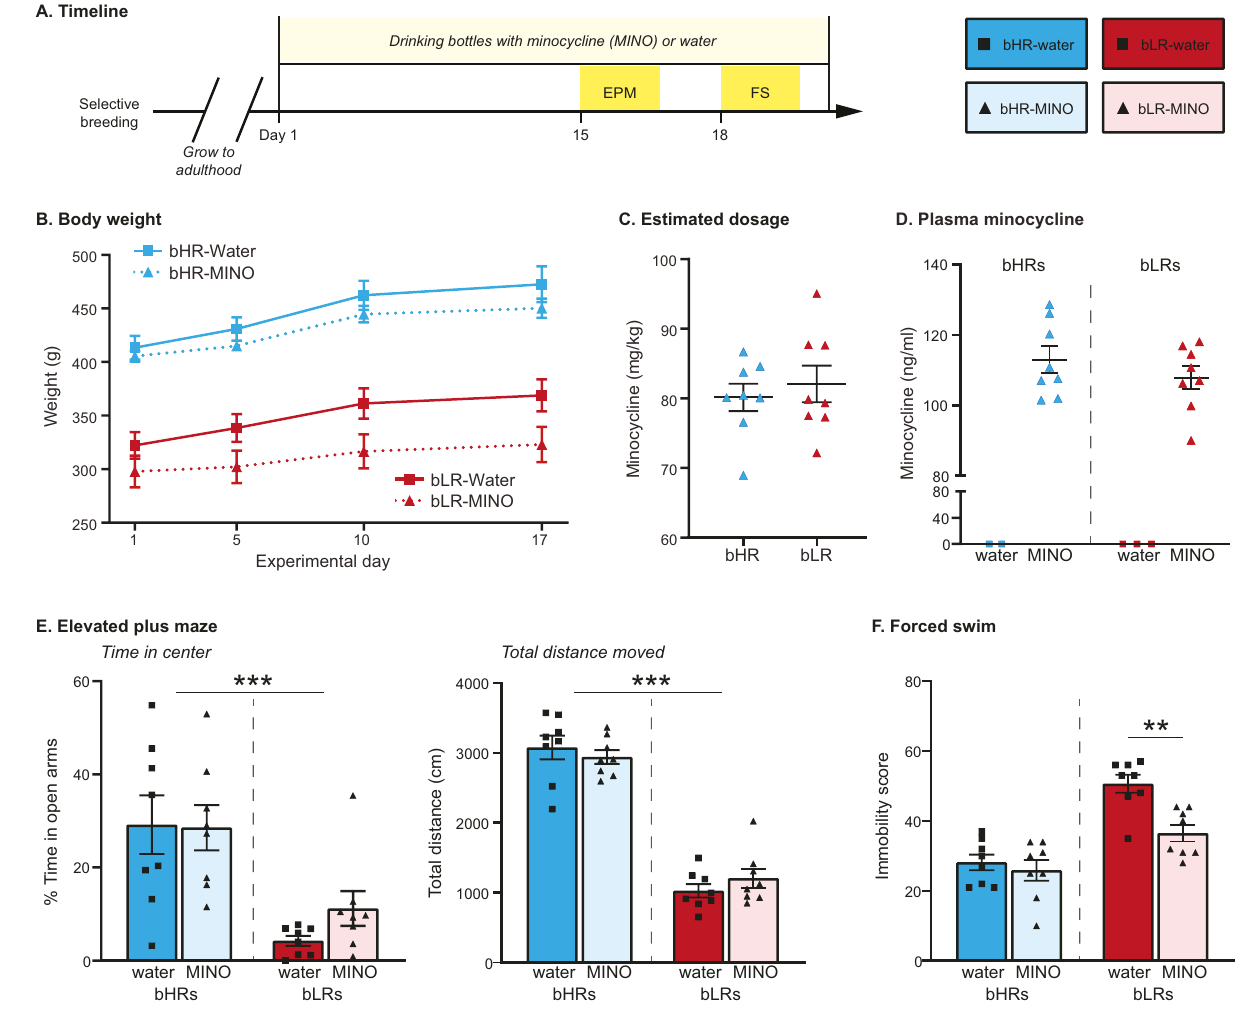
Fig. 2 Comparison of minocycline effects in bHRs and bLRs. Minocycline effects were initially assessed for a single proxy measure of anxiety (Elevated Plus Maze, EPM) and depression (Forced Swim, FS) in both bHRs and bLRs. A Schematic of administration and testing timeline; Day 1 = fi rst day of minocycline administration. B Body weight was measured periodically throughout minocycline administration and revealed faster growth rates in bHRs ( F 1,28 = 74.642, p < 0.001). Minocycline administration reduced weight gain overall ( F 1,28 = 4.617, p = 0.040), with no signi fi cant Line*Treatment interaction. C Minocycline dosages (mg/kg) were estimated by dividing body weight by consumption volumes and were similar in bHRs and bLRs. D Plasma minocycline measurements also indicated similar levels of circulating minocycline between bHRs and bLRs at the end of the experiment. E In the EPM, bLRs spent less time in the open arms overall (*** F 1,28 = 17.423, p < 0.001), but there was no effect of minocycline in either line. There was also an overall line difference in total distance moved (*** F 1,28 = 216.822, p < 0.001), but again, no effect of minocycline in either line. F In the forced swim test, a Line*Treatment interaction ( F 1,28 = 5.418, p = 0.027) showed that minocycline reduced immobility scores in bLRs (** t 14 = 4.048, p = 0.001) but not in bHRs ( t 14 = 0.605, p = 0.555). Data are expressed as mean ± SEM, with scatter plots overlaid to show individual data differences in gene expression, particularly in genes related to In summary, inhibition of microglia with minocycline treatment microglia function [25]. For this cohort, body weights measured at shifted social and depressive-like behaviors in bLRs. the time of perfusion were not signi fi cantly different between bHRs and bLRs (Fig. S3). When comparing Iba1 staining density, Divergent temperaments were associated with shifts in the we detected a trend for increased staining in bLRs compared to territory area of hippocampal microglia, despite similar total bHRs (Fig. 4D; p = 0.056). We then used non-biased stereological numbers of microglia sampling techniques to estimate the total microglia number We predicted that the extreme differences in inborn temperament within each sub-region. The effects of line did not vary by sub- in bHR/bLR rats were associated with underlying variation in the region (all Line*Region : p > 0.05); data were therefore combined baseline status of microglia, either in the total number of across sub-regions for each subject. The estimates for total microglia, or in their activation state. To test this prediction, we number of microglia were similar between bHRs and bLRs, with a generated a detailed, anatomical comparison of hippocampal trend for higher total microglia in bLRs (Fig. 4E; p = 0.085). When microglia populations in a separate cohort of experimentally naïve estimates were broken down by morphological category, for both bHRs and bLRs using immunohistochemical labeling of microglia lines, most microglia were classi fi ed as rami fi ed (mean ± SEM: (Fig. 4A – C). We focused our anatomical analysis on the bHRs = 91.34 ± 1.44%; bLRs = 89.43 ± 1.63%). Again, estimated hippocampus, as this region is characterized by robust bHR/bLR